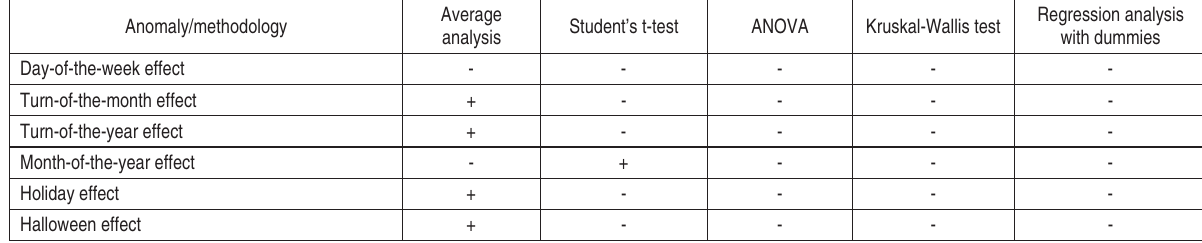
Table 2. Overall results for UX